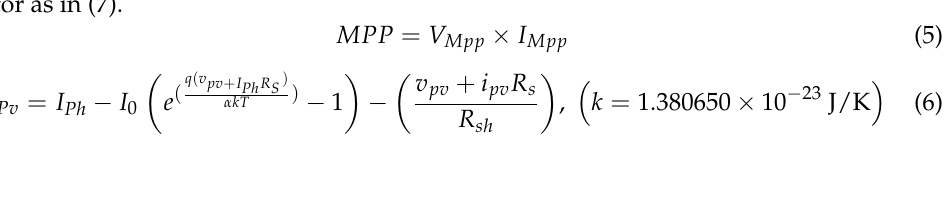
Table 1. Comparison between indoor and outdoor parameters.